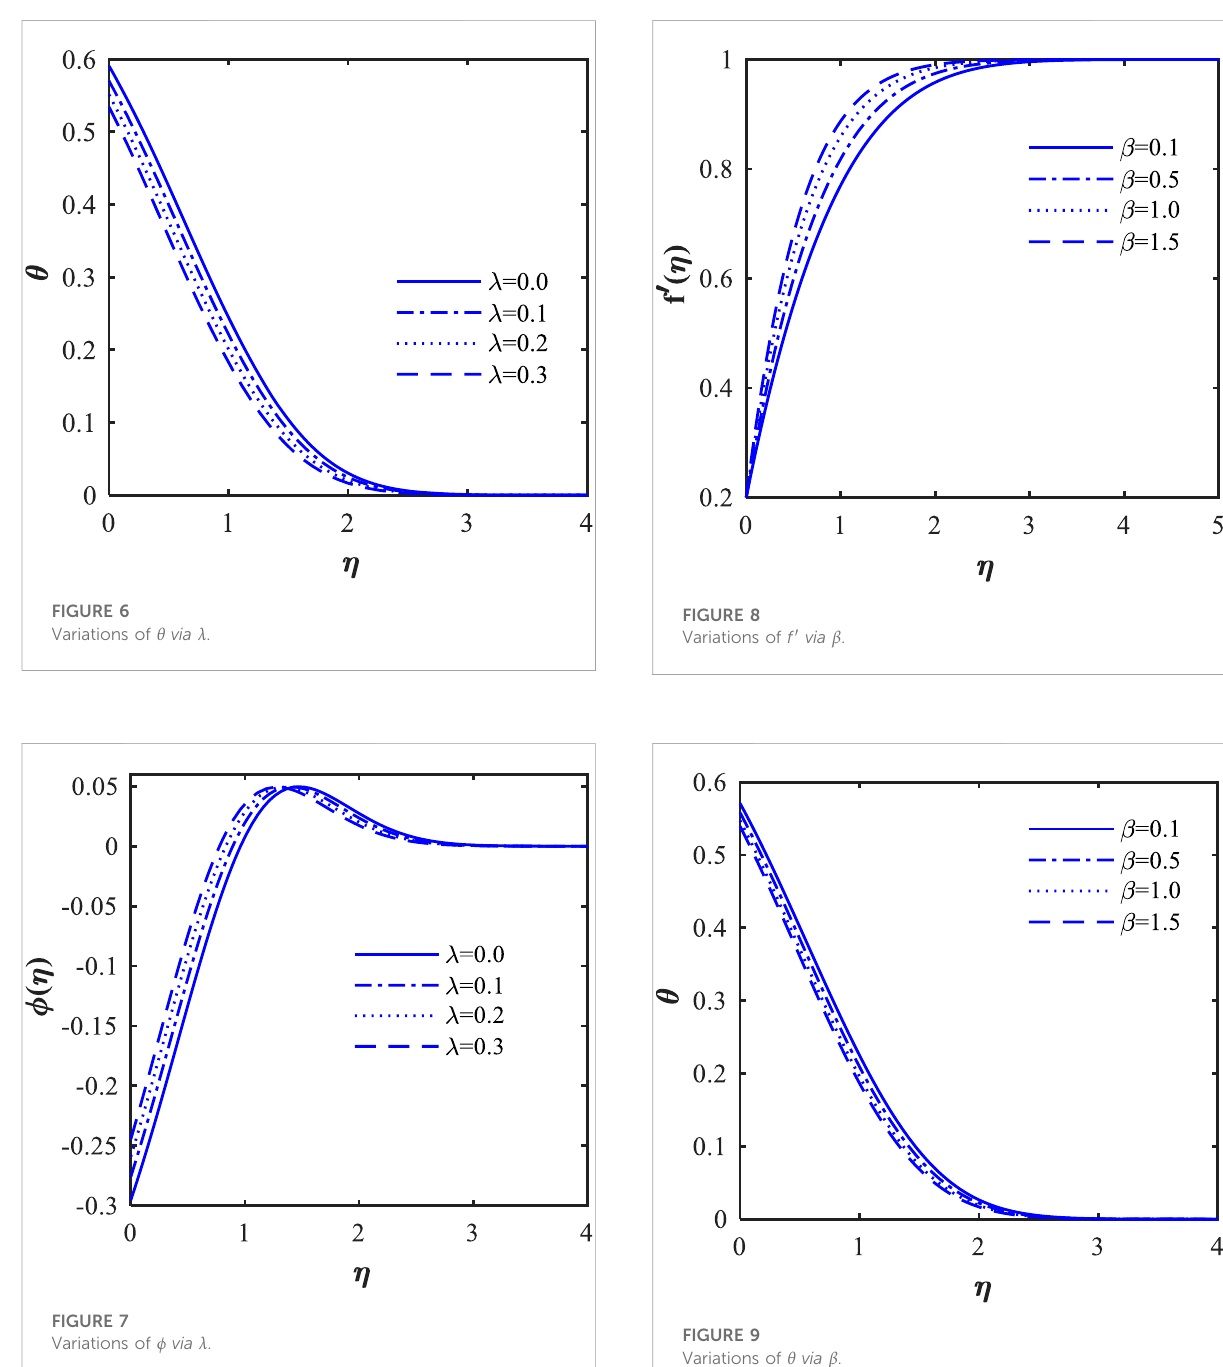
FIGURE 9 Variations of θ via β